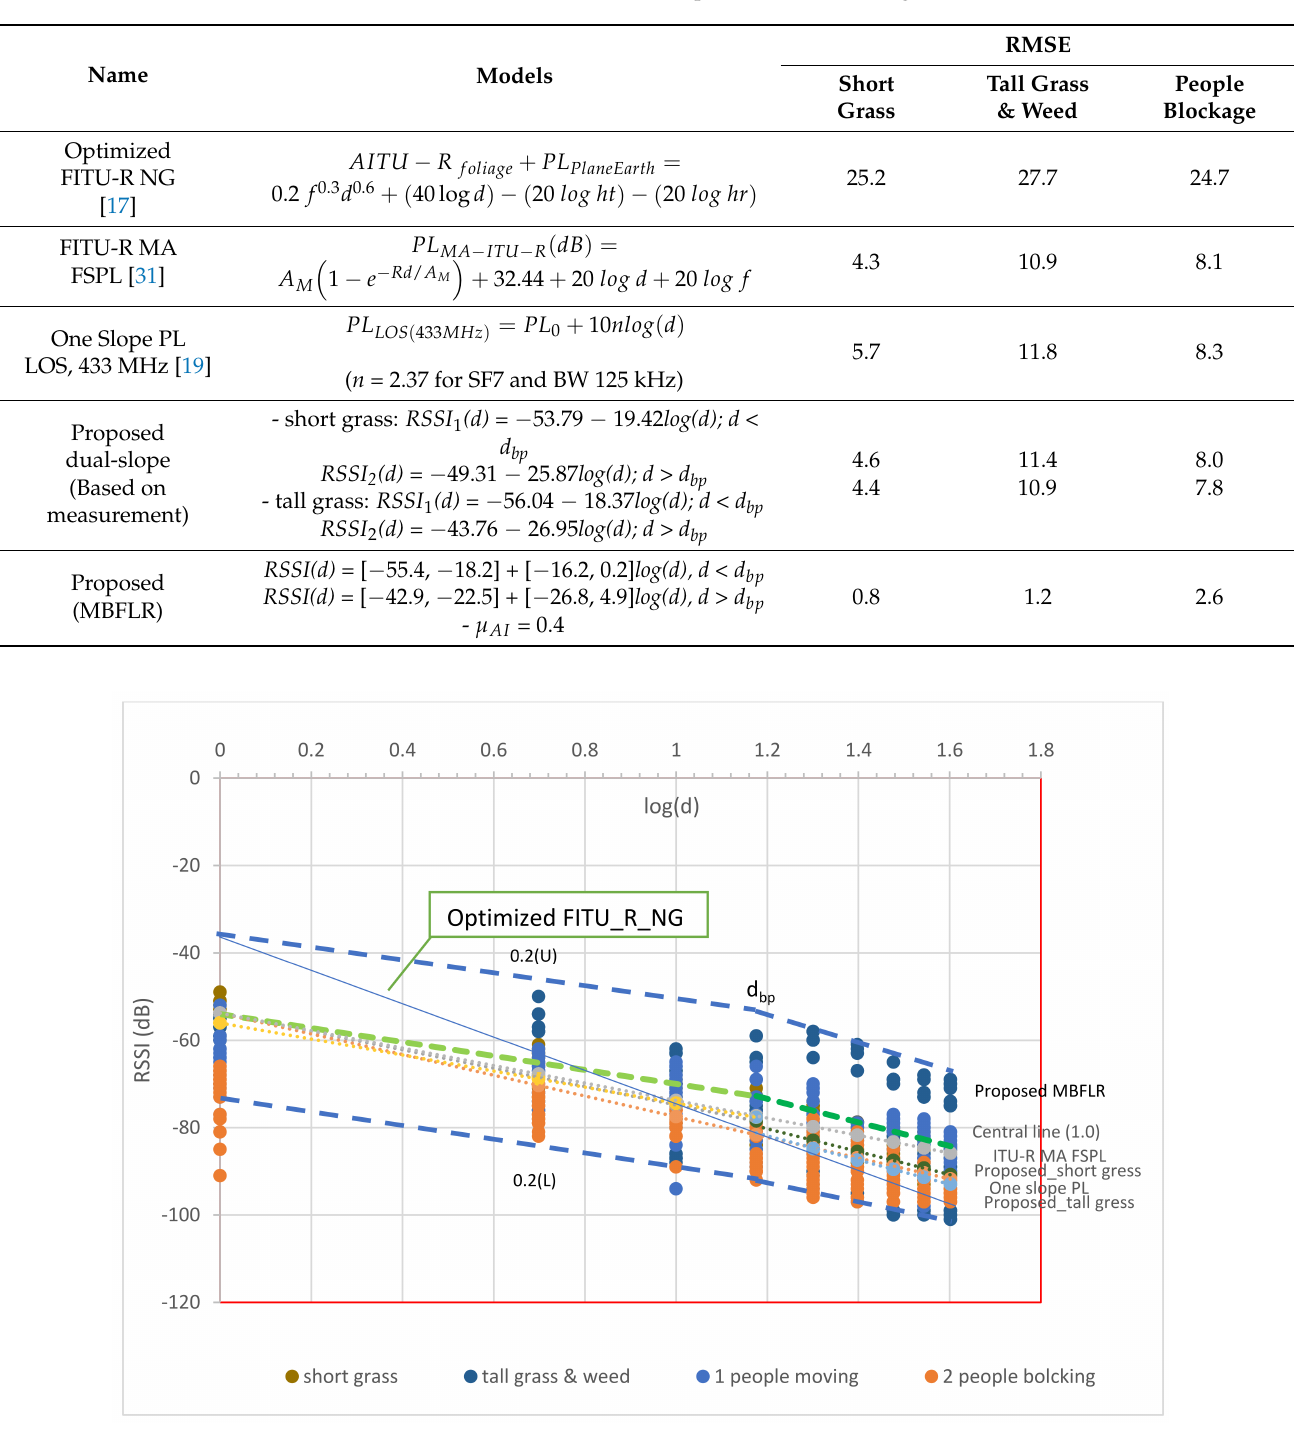
Figure 14. Comparisons between the proposed model and the other